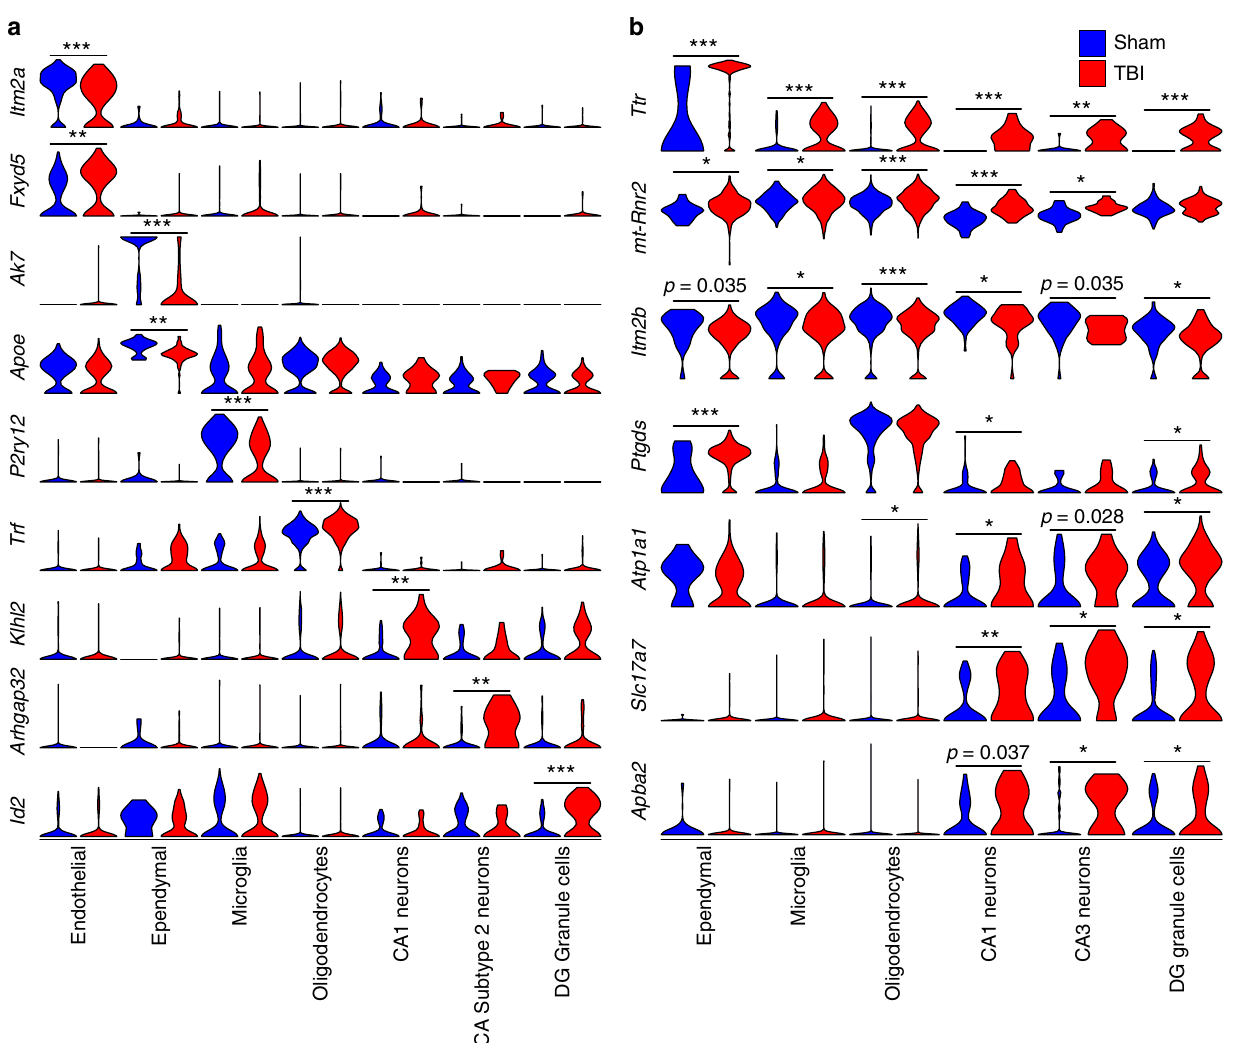
Fig. 6 Top cell-type speci fi c DEGs and pan-hippocampal DEGs. The normalized expression of cell-type speci fi c ( a ) and pan-hippocampal ( b ) DEGs between Sham and TBI samples is displayed as violin plots. Single cells from Sham samples are indicated by the blue plots and single cells from TBI samples are indicated by the red plots. Likelihood-ratio test was used to determine statistical signi fi cance between Sham and TBI groups and FDR was calculated to correct for multiple testing. *FDR < 0.02, **FDR < 1 × 10 − 4 , ***FDR < 1 × 10 −